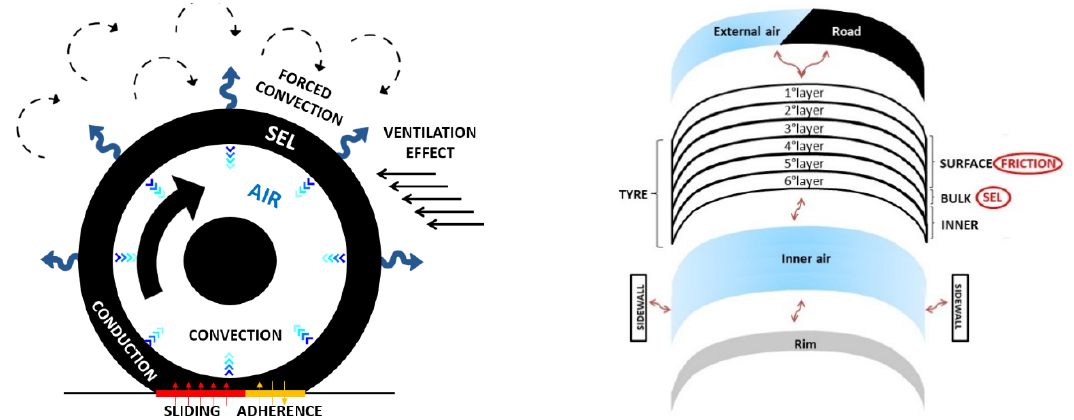
Figure 1. thermoRIDE model scheme.